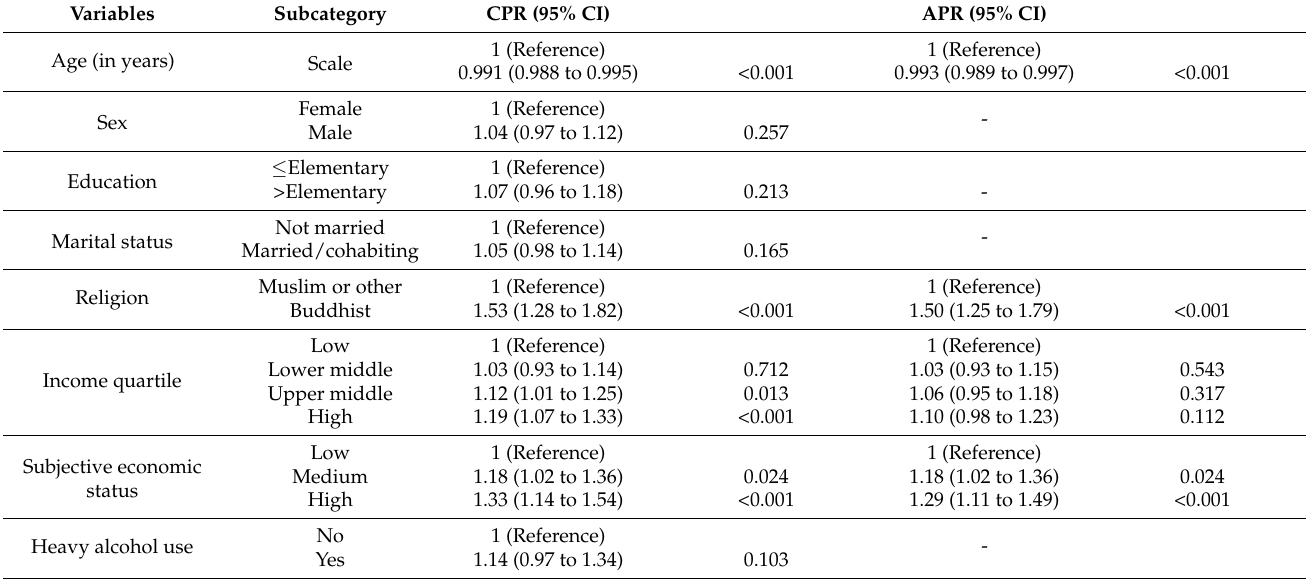
Table 3. Prevalence ratios for the associations between sociodemographic factors, health factors, and successful aging, HART